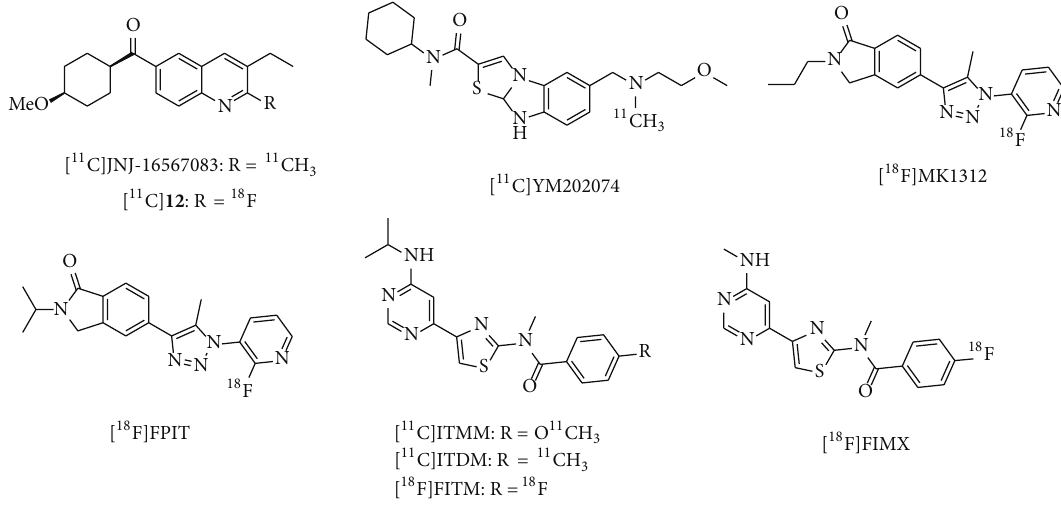
Figure 7: Chemical structure of imaging probes for mGluR1.